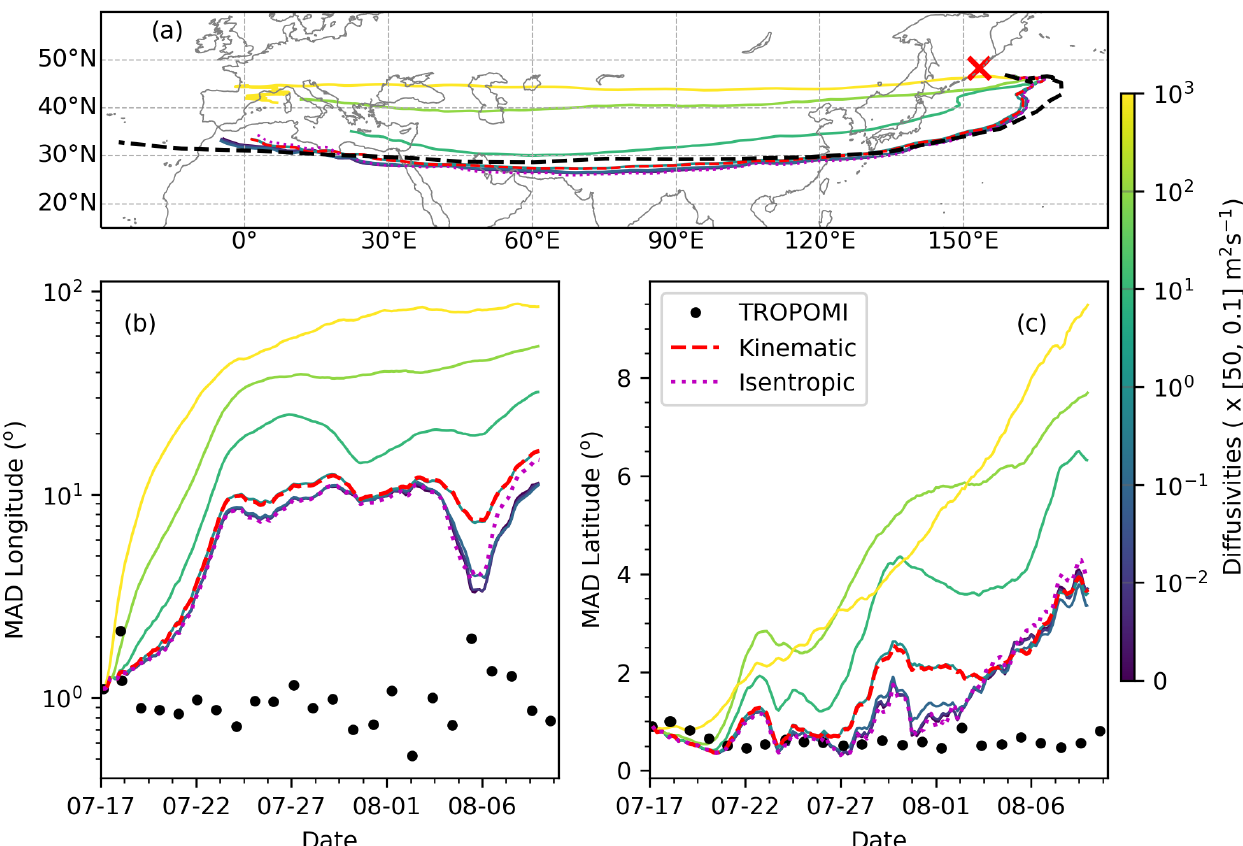
Figure 18. Same as Fig. 17 but for simulations driven by different diffusivity settings (see color